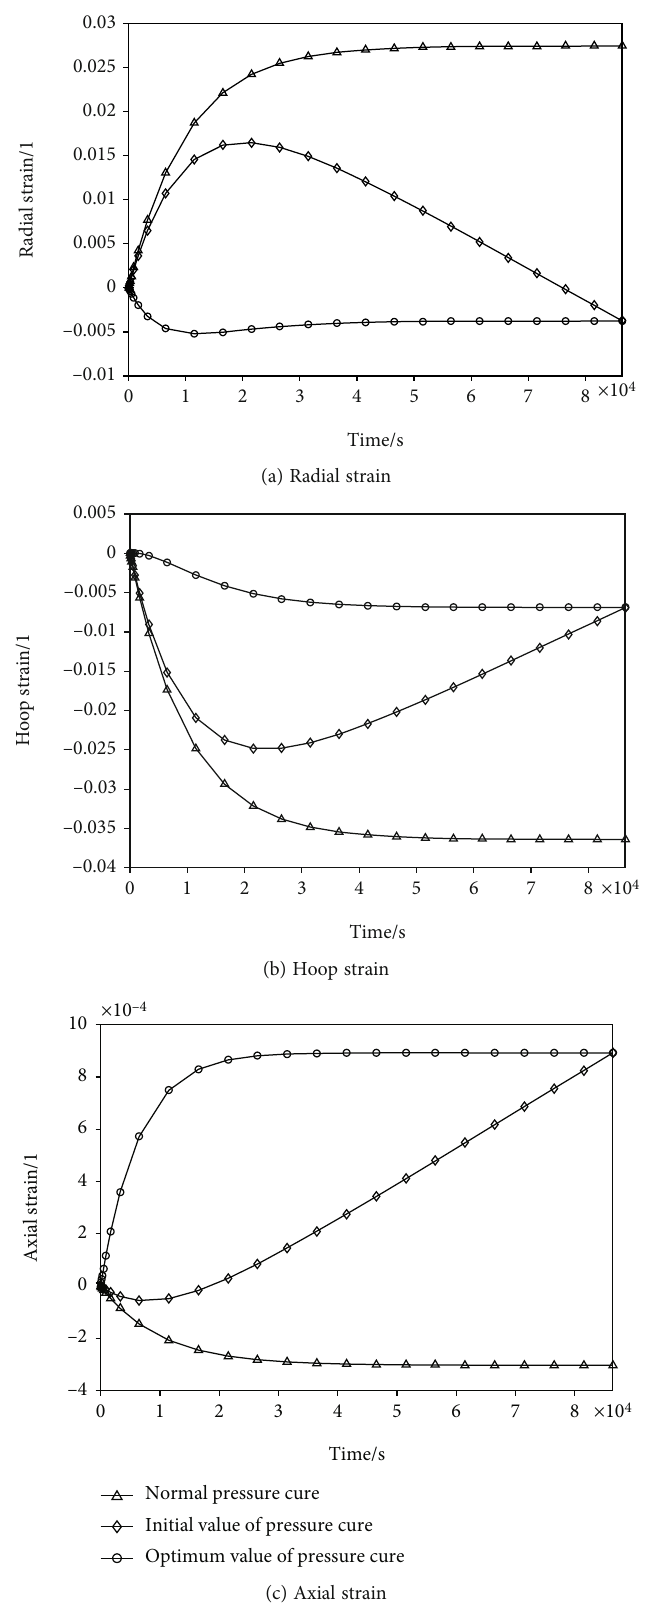
Figure 14: Strain comparison during pressure relief and